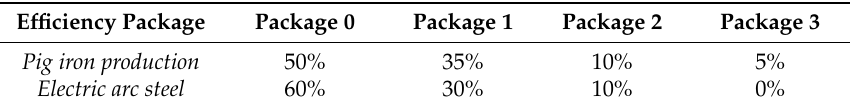
Table A4. Examples of implementation rates of energy efficiency packages in China in the 2030 t echnology baseline for selected products of the Iron and Steel